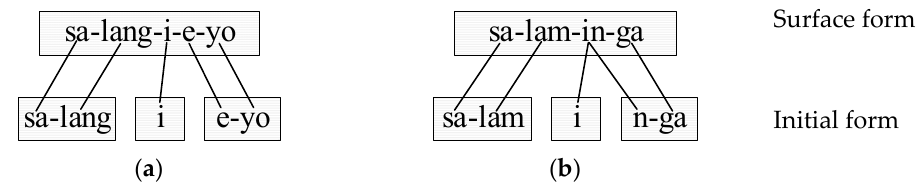
Figure 2. Illustrations of syllable associations between the surface and initial